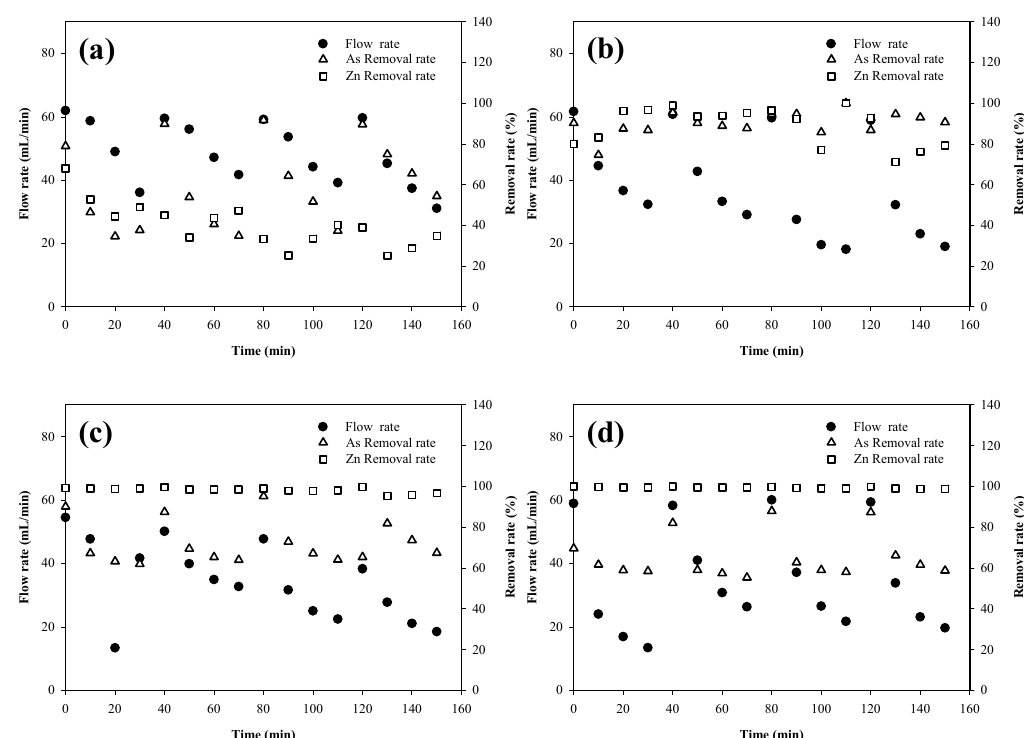
Figure 7. Effect of solution pH on the flow rate and Zn and As removal rates during the hybrid ion-exchange fabric/ceramic membrane processing of As + Zn + Kaolin solution: (a) pH 4, (b) pH 6, (c) pH 8, and (d) pH 10.